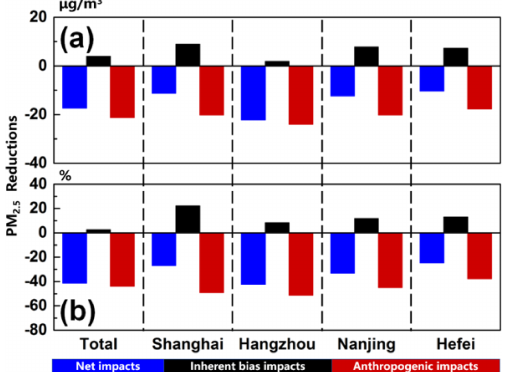
Figure 8. The impacts of anthropogenic emission controls and inherent biases on PM 2 . 5 concentrations during the G20 summit over the whole domain as well as in four representative cities (i.e., Shanghai, Hangzhou, Nanjing, and Hefei). Panels (a) and (b) refer to the changes in absolute values and relative percentages, respec- tively. Inherent biases are mainly due to the prior anthropogenic